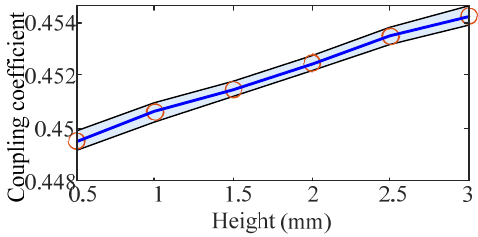
Figure 16. Fitting curve with different heights.